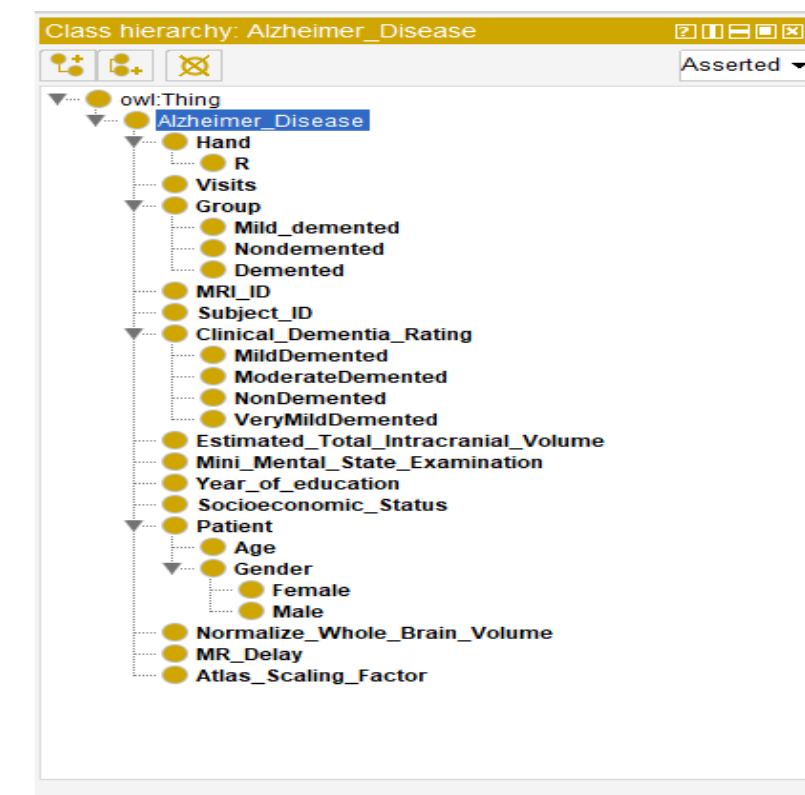
Figure 20. Classes Hierarchy of Alzheimer Disease in Protégé Software.